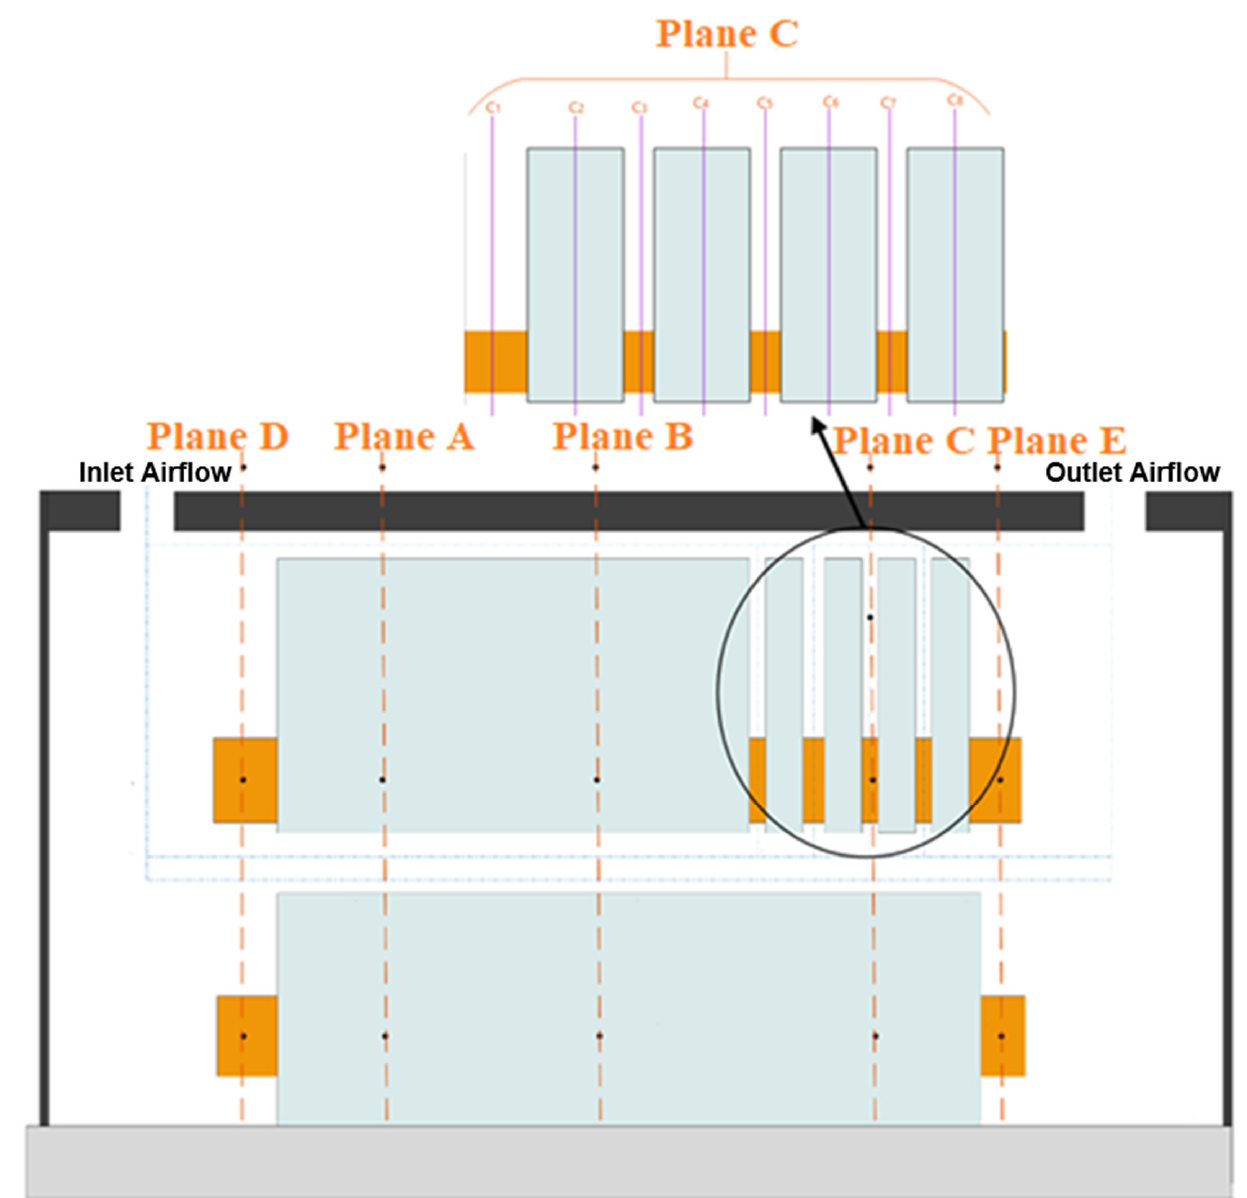
Figure 1. Multiple model plane thermal